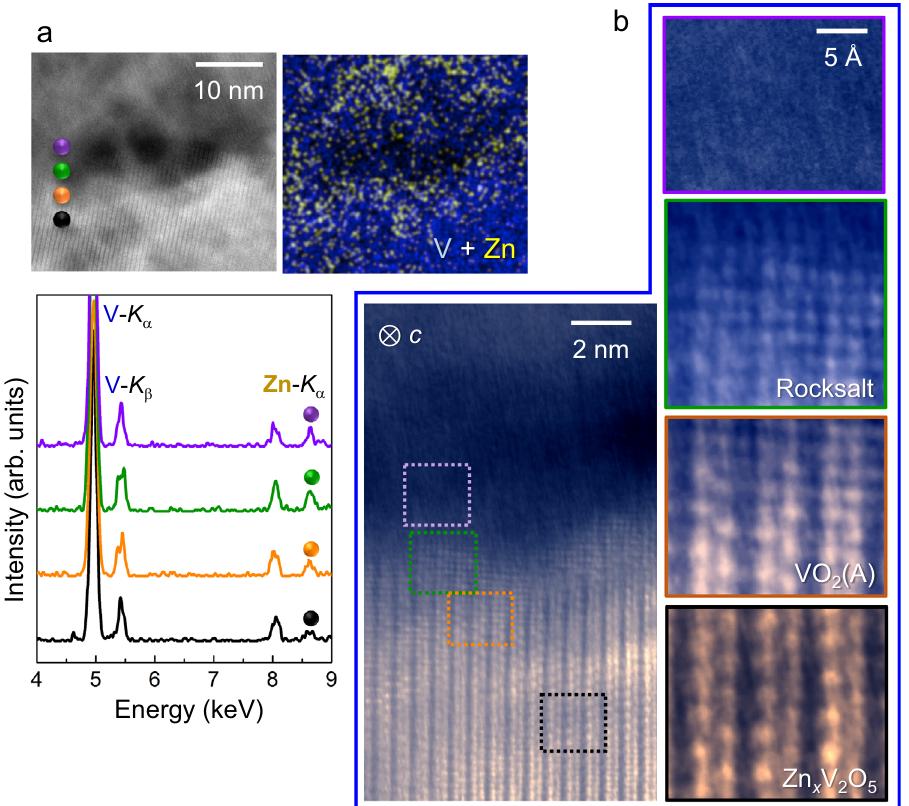
Fig. 7 Smooth transformation behavior during Zn insertion in the c projection. STEM images taken in the c projection and EDS results are provided to consistently show smooth transformation behavior as well. a As denoted by small spheres in color in the image, consistent variation of Zn concentration near the grain-boundary is shown in a series of EDS spectra along with the compositional map. b This ADF image and the enlargements for the local regions denoted by squares visualize the continuous phase